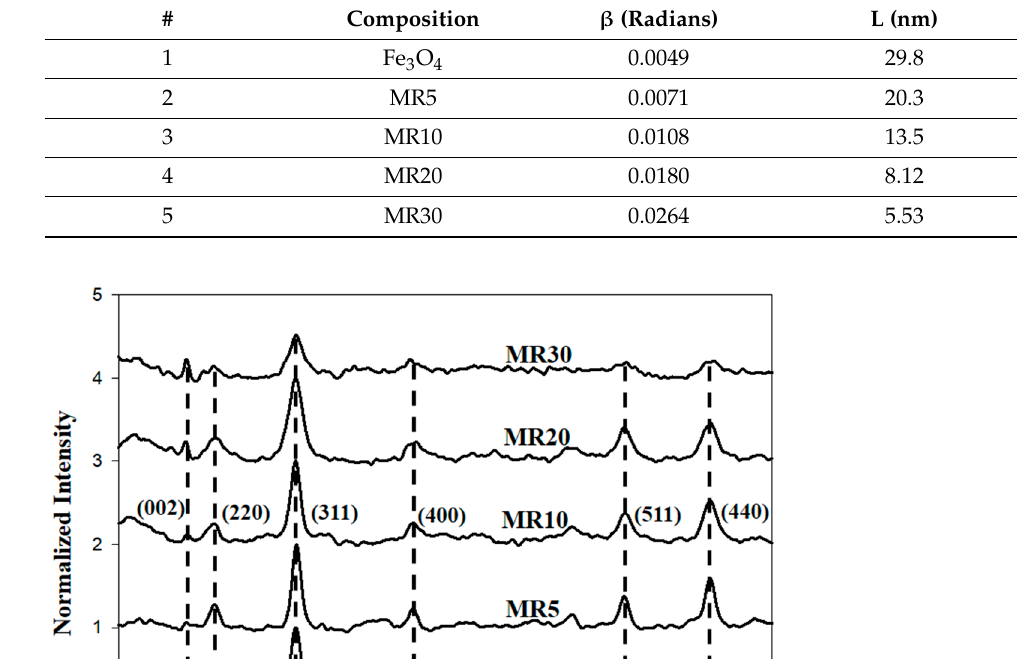
Table 2. The crystalline domain size (L, nm) for the different Fe 3 O 4 /rGO composites.